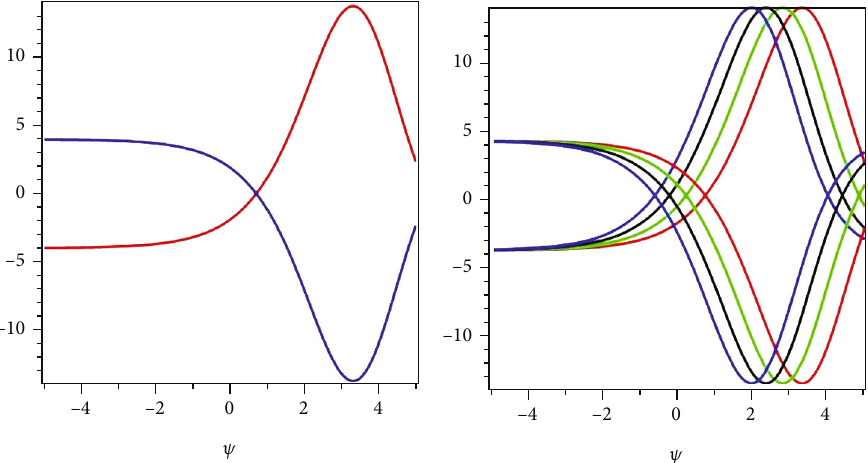
Figure 2: (a) 2D upper and lower fuzzy branch plots of the approximate series result and (b) the di ff erent fractional order of ς .